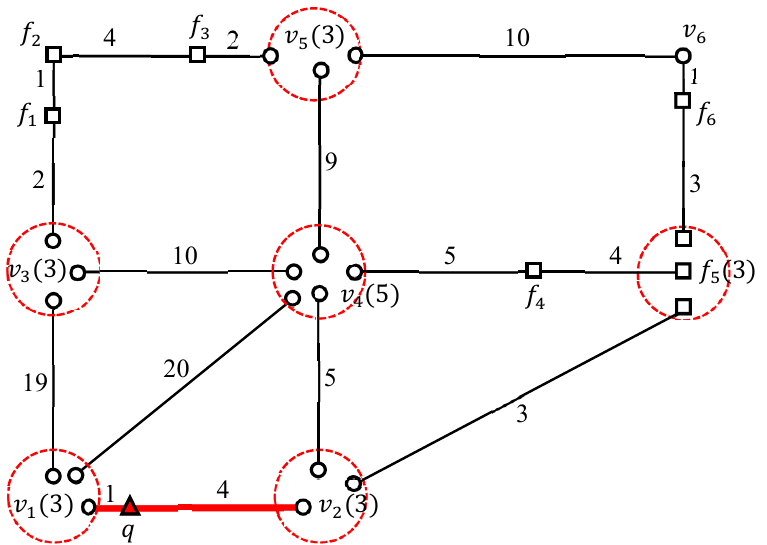
Figure 4. Segmentation of an example road network using road